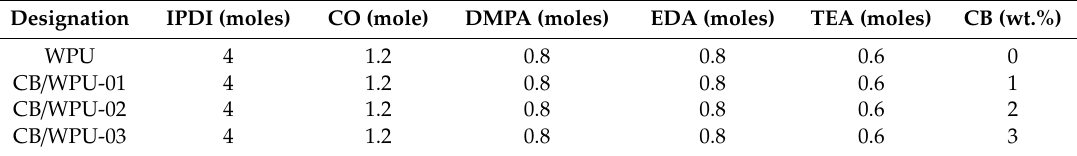
Table 1. Formulas of the CB / WPUs.